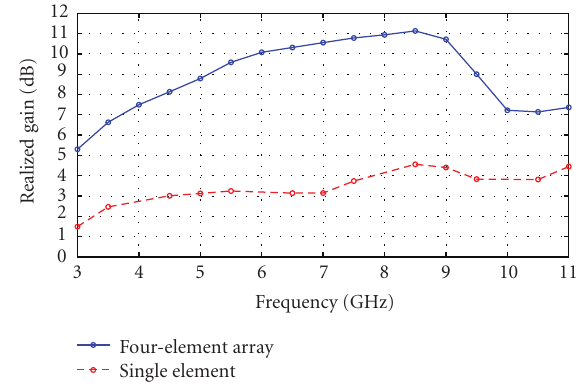
Figure 18: Simulated realized gain curves of the four-element UWB array at element spacing d = 28 mm compared to a single antenna